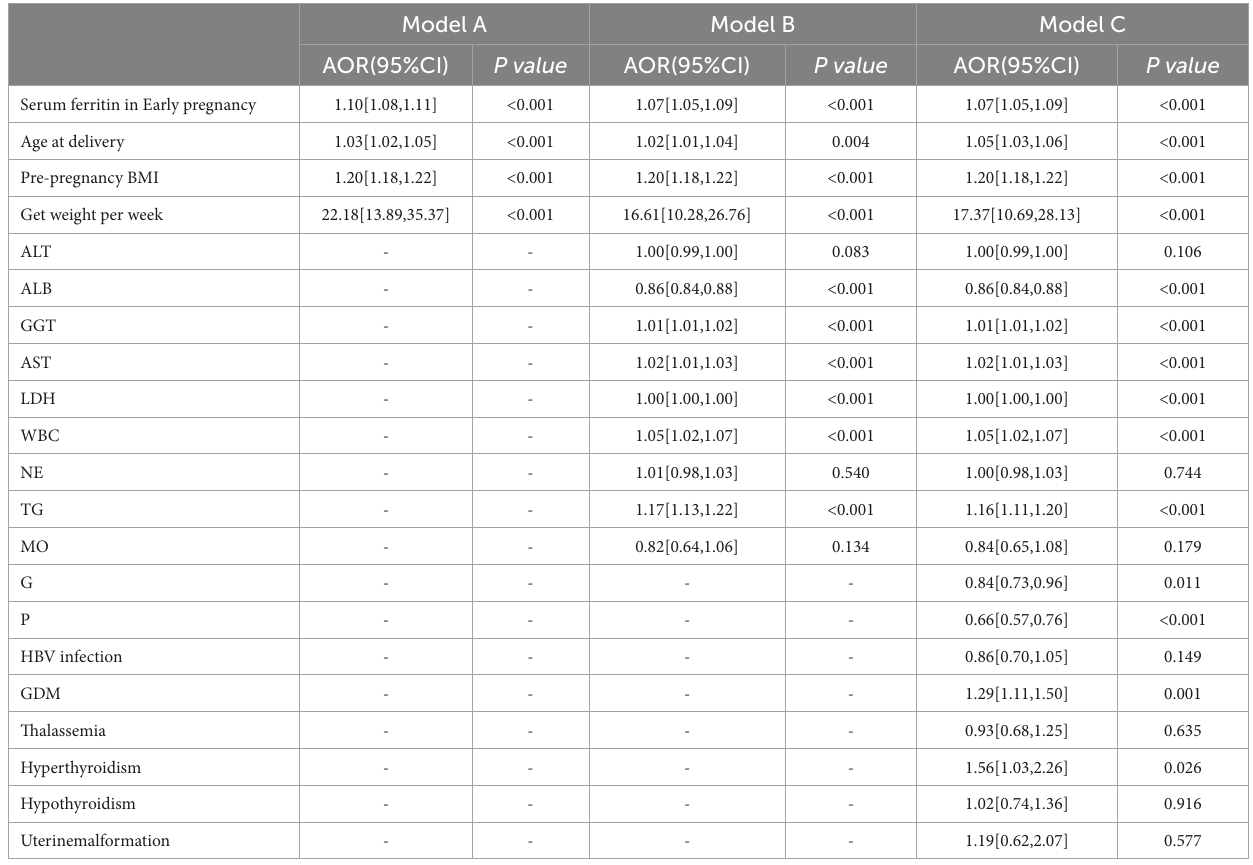
TABLE 2 Adjusted ORs for HDP according to serum ferritin in early